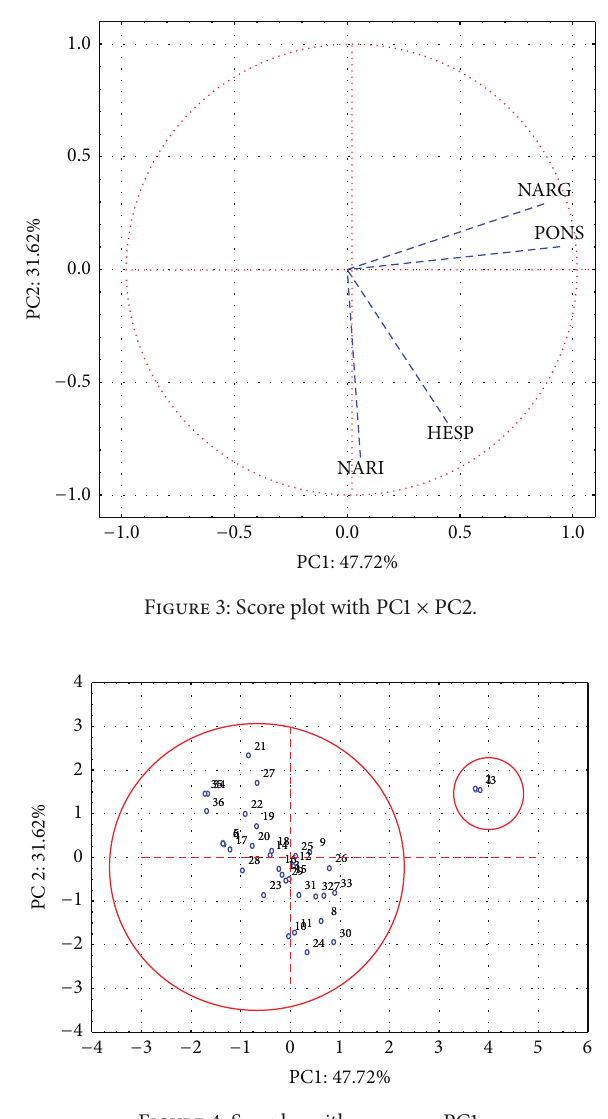
Figure 4: Samples with scores on